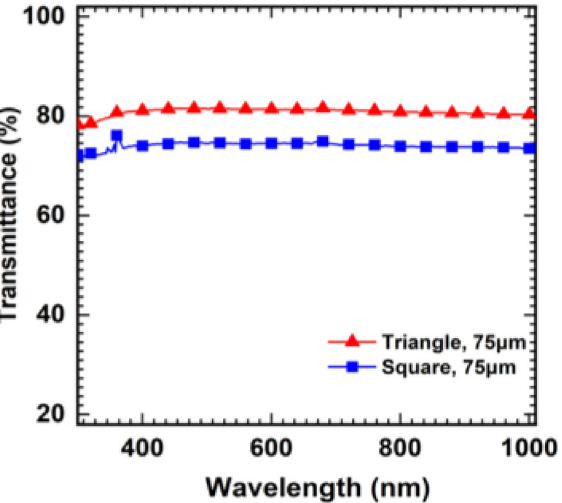
Figure 5. Total transmittance spectra of the fabricated transparent electrode with a 75 um drop distance.